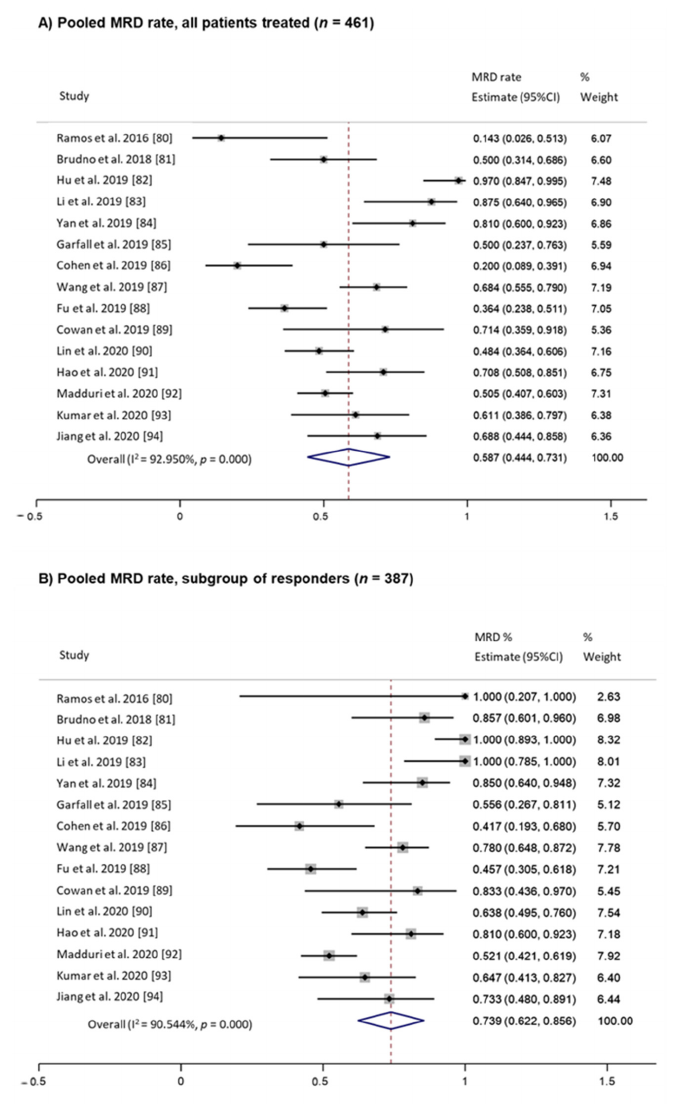
Figure 1. Pooled MRD rate for CAR T cell therapy in MM: ( A ) estimate in all patients treated ( n = 461). ( B ) Estimate in responder subgroup ( n = 387). Data were extracted from Mohyuddin et al. meta-analysis [79]. Random effect model by using metaprop command in Stata 16/IC software was performed.